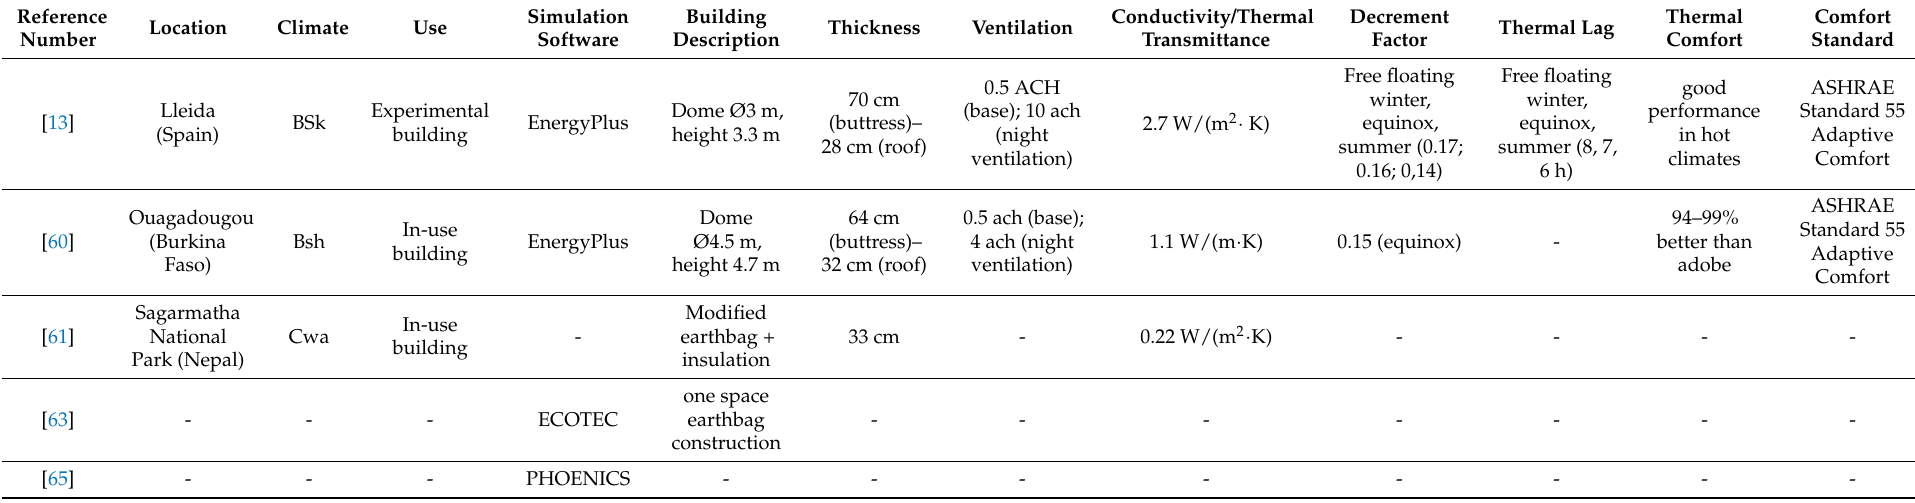
Table 5. Building characteristics and thermal performance of the earthbag simulated studies.